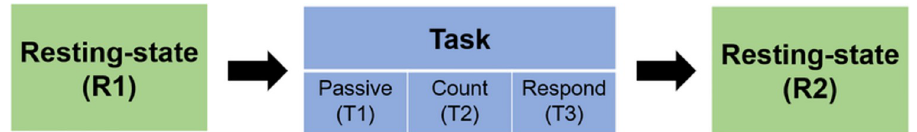
Fig 1. Experimental design of the rest-task-rest paradigm (RTR) which includes two resting-state conditions (pre- and post-task resting-state, R1 and R2) and the task condition composed of three subtasks (passive (T1), count (T2) and response (T3)) of the visual oddball paradigm